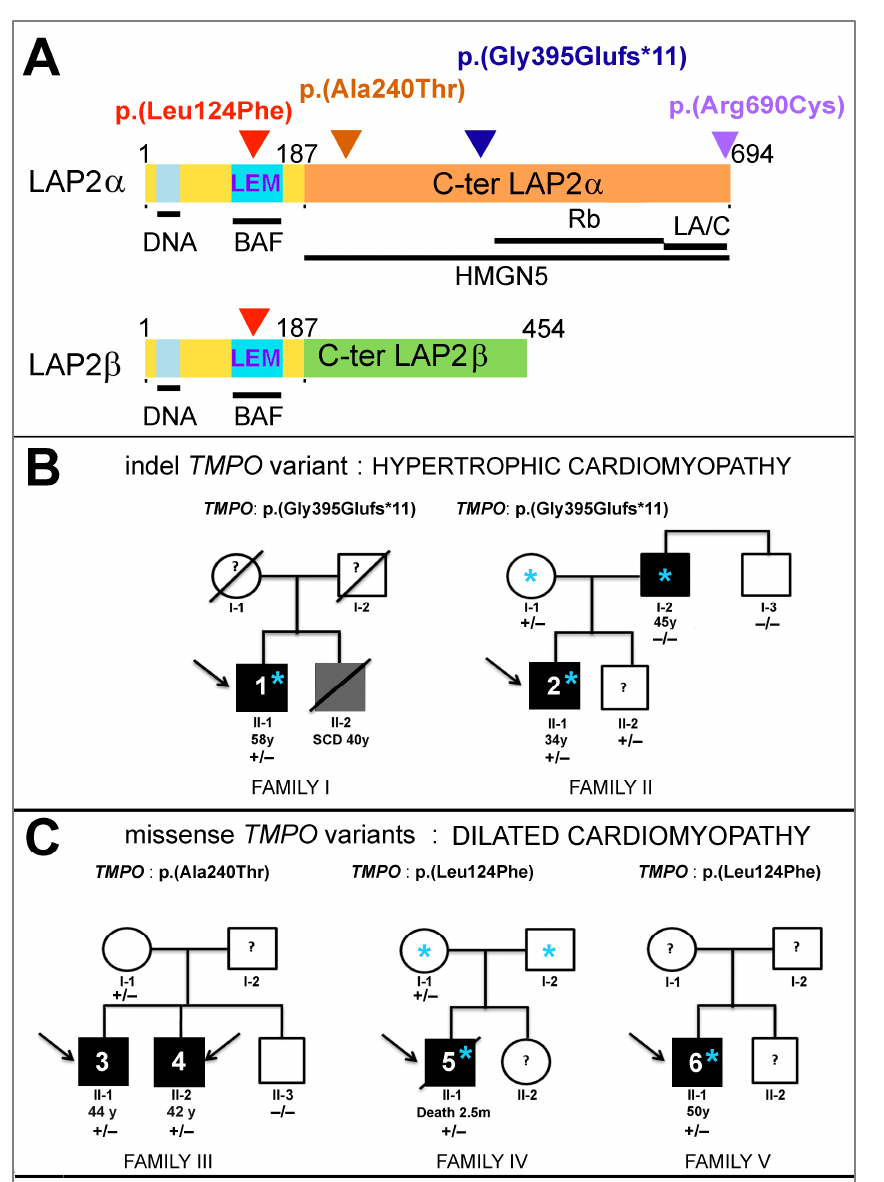
Figure 1. Identification of three rare TMPO /LAP2 variants in patients with cardiomyopathies . ( A ) Localization of variants in LAP2 proteins. LAP2 α and LAP2 β have 694 and 454 amino acids (a.a), respectively. The region common to all LAP2 isoforms ( α , β ...) includes the N-ter (a.a 1–187) encoded by exons 1, 2 and 3 (in yellow) and contains a LEM-like (in pale blue) and a LEM domain (in blue). The C-ter regions specific to LAP2 α (exon 4) and LAP2 β (exons 5–10) are depicted in orange and green, respectively. The mutations identified in patients with cardiomyopathies and their position on the proteins are indicated (arrow heads). The LAP2 α domains involved in binding DNA or the protein partners BAF, Rb, lamins A/C (LA/C) and HMGN5 are underlined. ( B , C ) Pedigrees of the five families carrying new rare TMPO mutations. Generations are identified by their Roman numerals below the symbol. Arabic numerals denote each individual in a generation. Squares represent men, and circles represent women. Index cases were indicated with an arrow. Open and filled symbols are unaffected and affected individuals, respectively; diagonal lines indicate deceased subjects. Age (years, y; months, m) at diagnosis or death is indicated, SCD: sudden cardiac death. Echocardiography and electrocardiograms were reported as normal for the carrier mothers in Families II, III and IV. Stars * (in blue) indicate patients that underwent exome sequencing. + means an allele carrying the LAP2 mutation of interest, − means no LAP2 mutation.